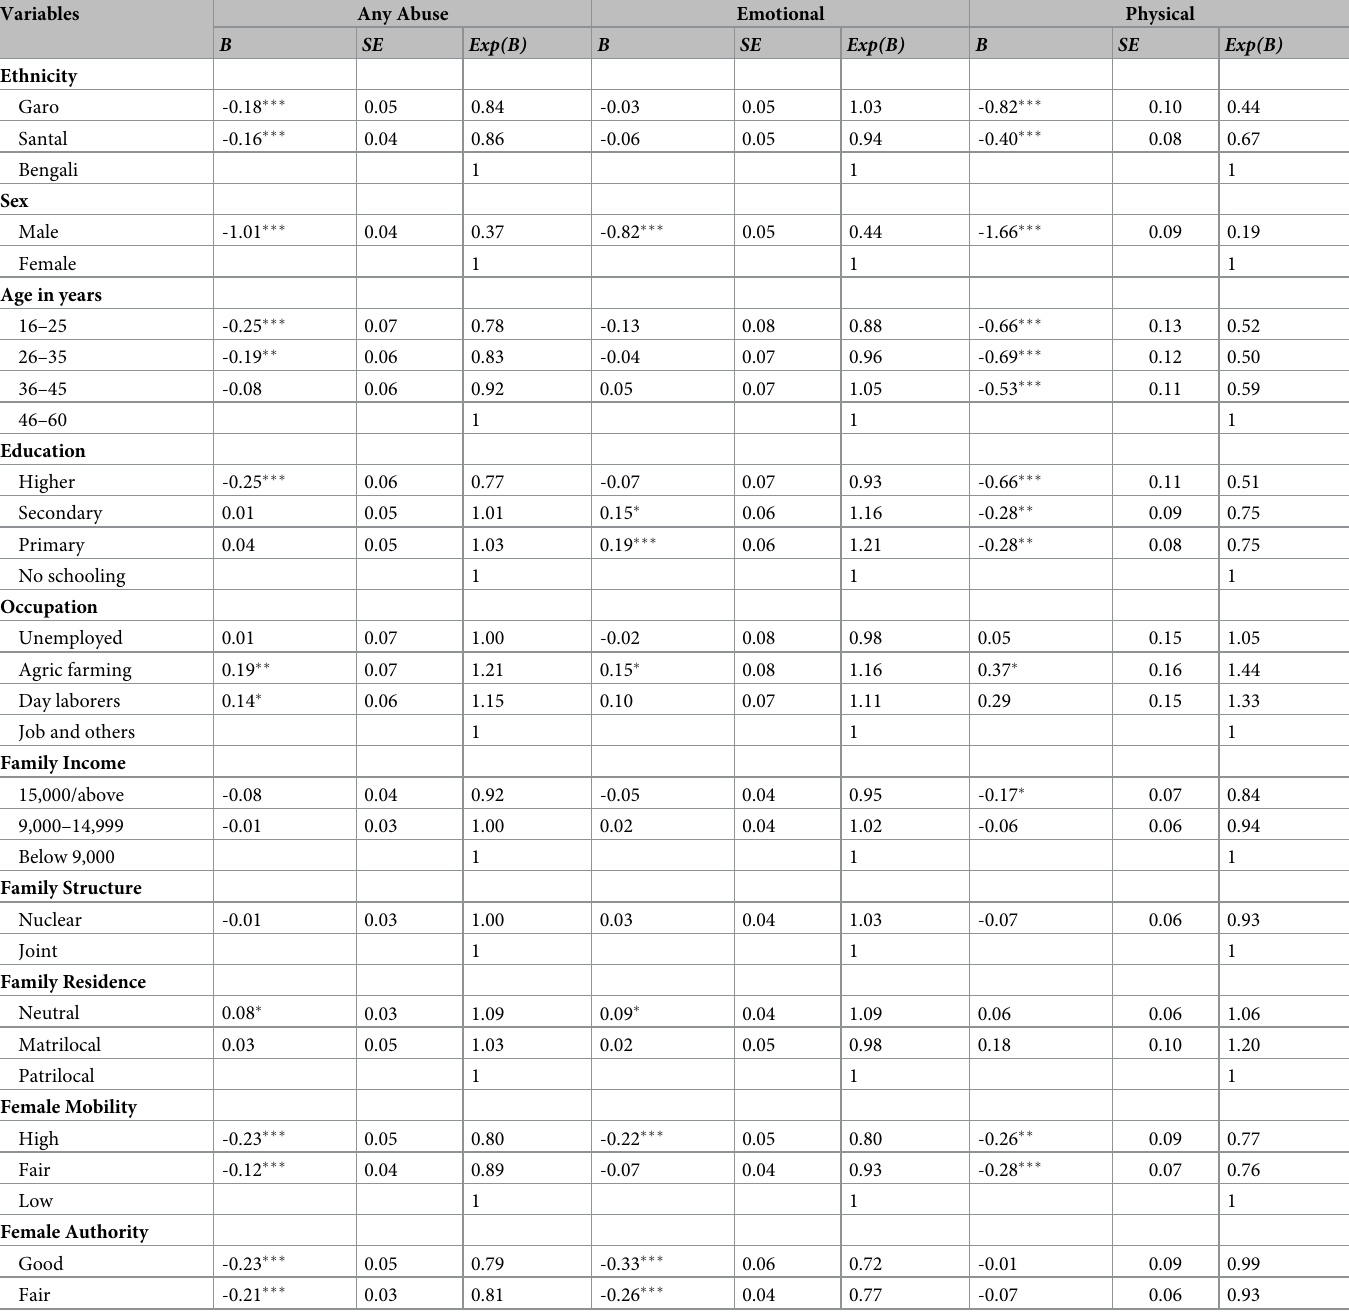
Table 4. Multivariate poisson regressions for the events where wife abuses are accepted, N =